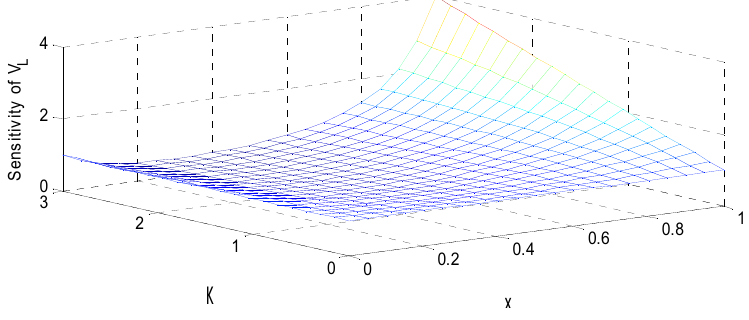
Figure 5. Sensitivity analysis in displacement-to-voltage conversion.